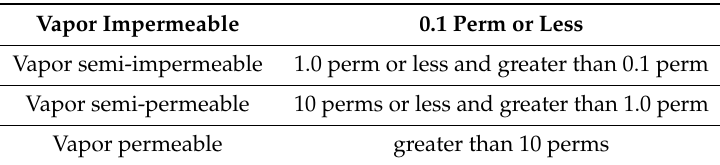
Figure 2. Water vapor permeability of bio-based insulations and EPS. 161 Table 1. Building materials permeance